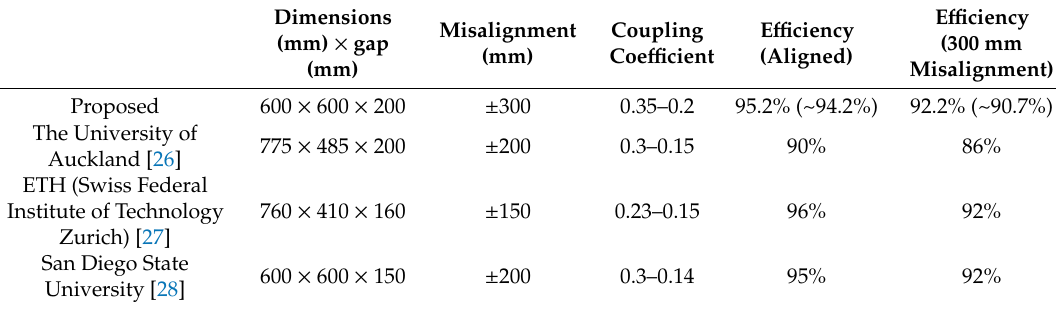
Figure 28. System e ffi ciency at aligned and misaligned positions. Figure 28. System efficiency at aligned and misaligned positions. Table 4. System output parameters and comparison with existing Table 4. System output parameters and comparison with existing literature.